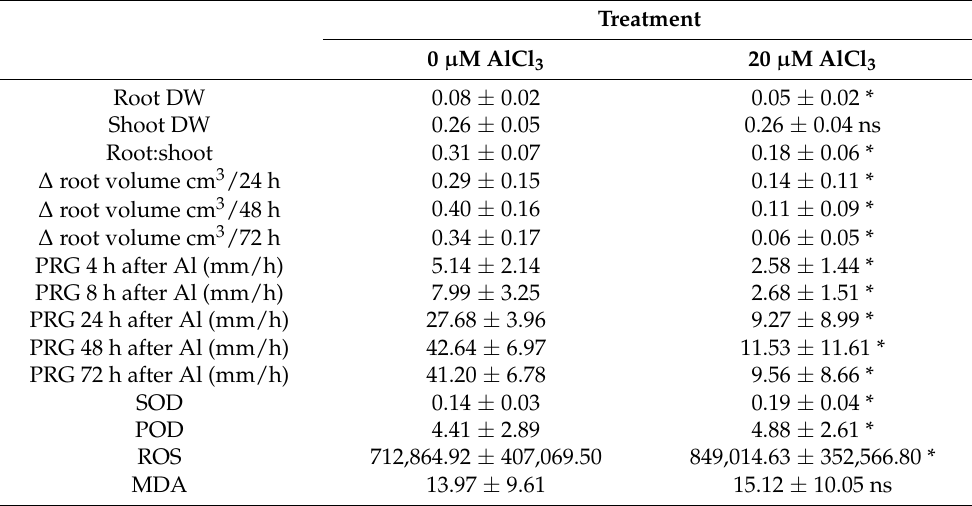
PRG 48 h after Al